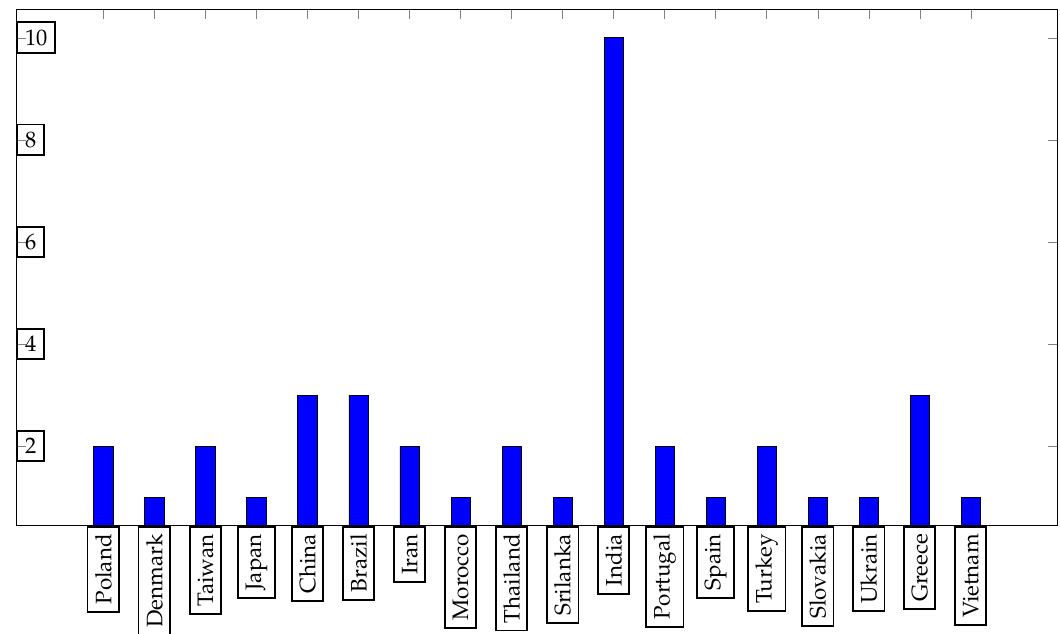
Figure 2. Country-wise classification of studies on foreign exchange market prediction.